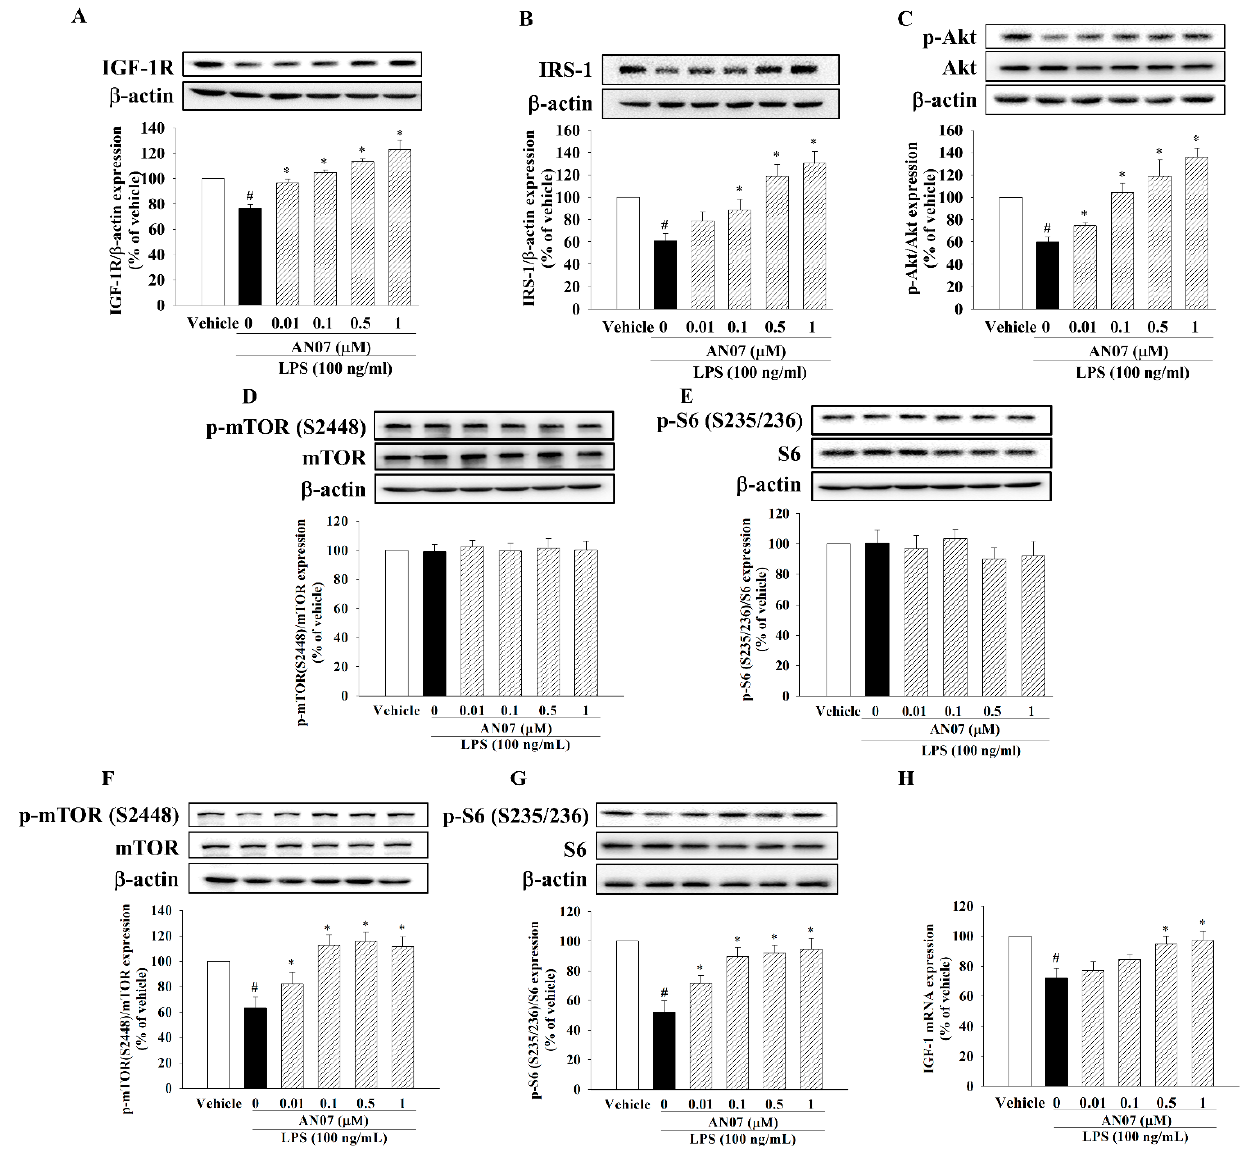
Figure 6. AN07 improved LPS-induced reduction of protein synthesis pathway in C2C12 myotubes. Myotubes were pretreated with AN07 (0.01–1 µ M) for 1 h followed by LPS (100 ng/mL) treatment for 24 h. The protein expressions of ( A ) IGF-1R, ( B ) IRS-1, ( C ) p-Akt/Akt, ( D ) p-mTOR (S2448)/mTOR, and ( E ) p-S6 (S235/236)/S6 were measured by Western blotting. ( H ) The IGF-1 mRNA expression was measured by qPCR. ( F , G ) For short-term LPS treatment, myotubes were pretreated with AN07 (0.01–1 µ M) for 1 h followed by LPS (100 ng/mL) treatment for 12 h. The protein expressions of ( F ) p-mTOR (S2448)/mTOR and ( G ) p-S6 (S235/236)/S6 were measured by Western blotting. Densitometry analyses are presented as the relative ratio of protein/ β -actin or p-protein/protein and are represented as percentages of the control group. Data represent the mean ± SEM from six independent experiments (n = 6). # p < 0.05 vs. control group (vehicle only); * p < 0.05 vs. LPS-treated group according to Kruskal–Wallis test followed by Dunn’s